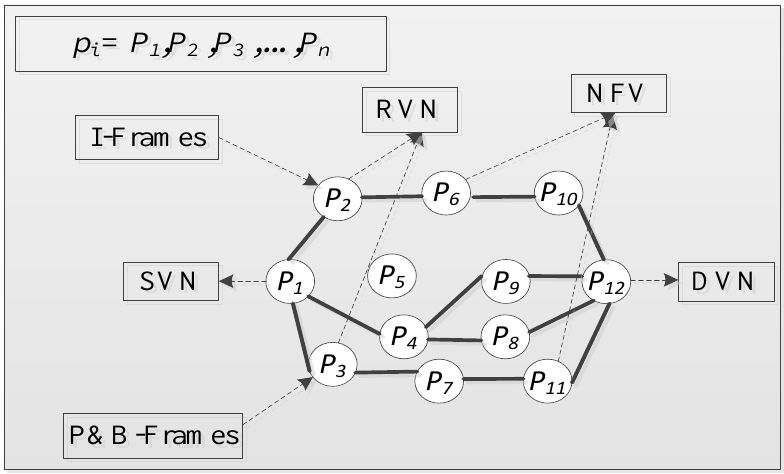
Figure 1. Video Streaming Forwarding in Multipath Settings.